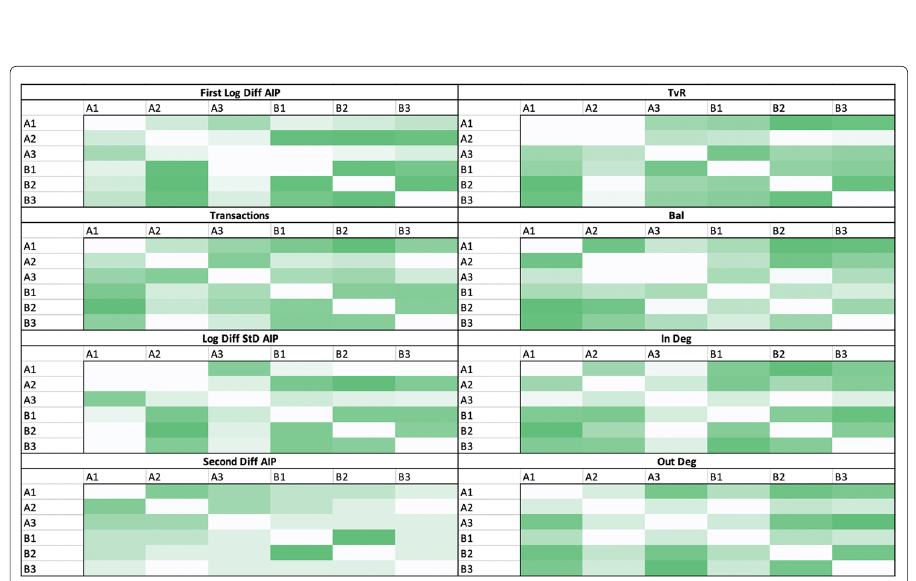
Fig. 11 Similarity Matrices of Feature Distributions for Hacking Groups A and